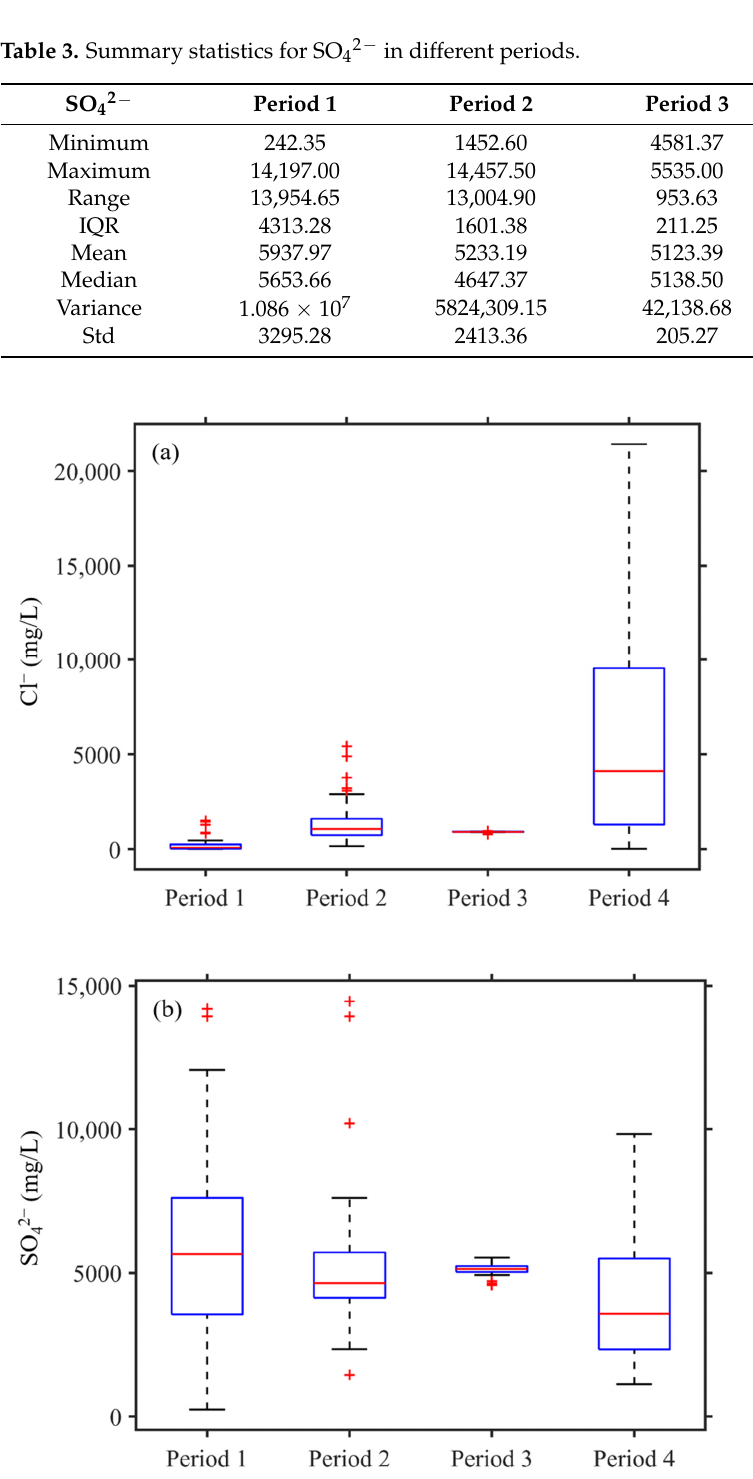
Figure 5. Box plot of ( a ) Cl − and ( b ) SO 42 − in different periods.